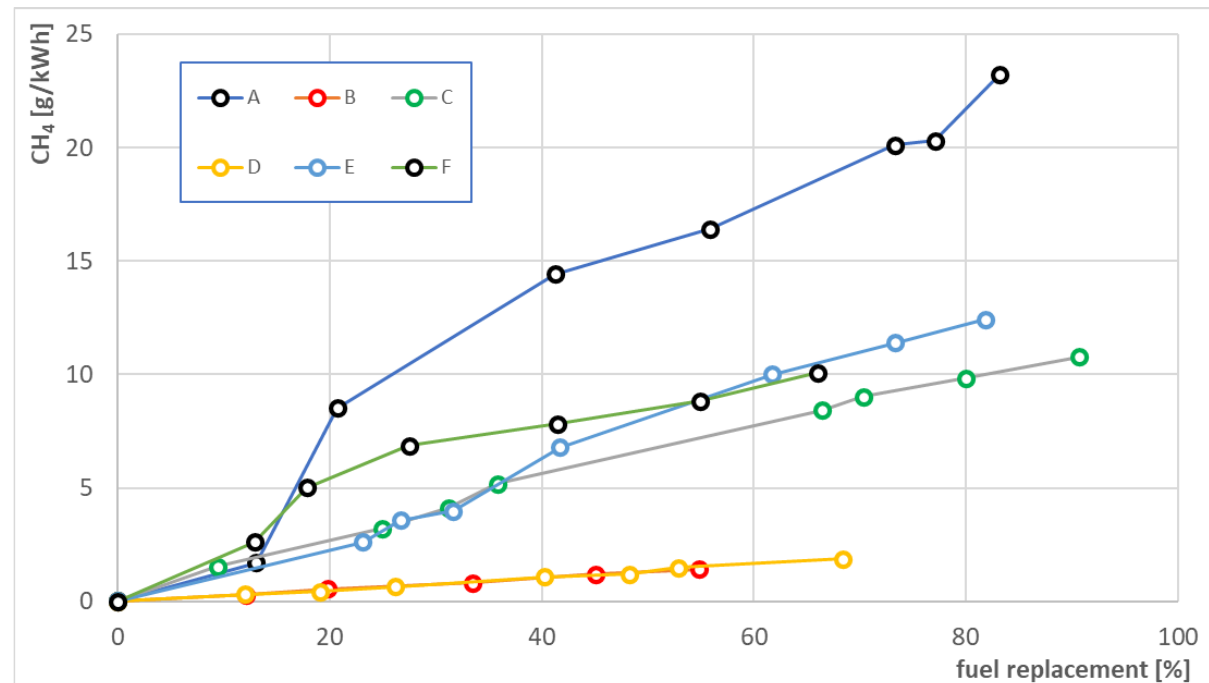
Figure 11. Curves from A to F showing engine’s emission of CH 4 (methane), for individual engine operating points, where the rotation speed, power, and torque were constant, as a replacement function of diesel fuel replaced by CNG.